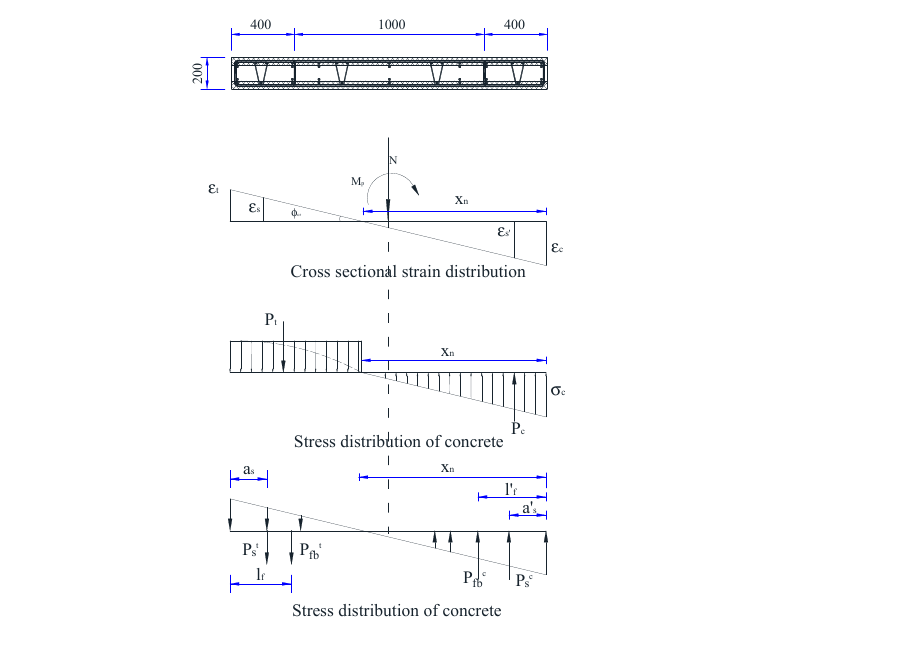
Figure 5. Stress and strain distributions under the cracking load. The stress and strain distribution under the cracking load considering the differences of concrete strength grade are shown in Figure 5. Under the cracking load, the stress in the prefabricated layer and that in the cast-in-site layer are different due to different strength grades of concrete. Hence, the distinction of concrete strength grade in these two kinds of wall layer should be considered as a stand-alone variable, as discussed below: (1) Neglecting concrete strength grade differences Generally, the lower concrete strength grade of the cast-in-site layer can be treated as the representative of the concrete strength grade of the overall cross section. Based on the equilibrium equation, the height of the compressive zone x n = 862.93 mm. From Equation (22), an inferred bending capacity under the cracking load is M cr = 484.09 kN m. Meanwhile, the corresponding cracking load is 161.36 kN, which has 23.16% error compared with the test result of 210